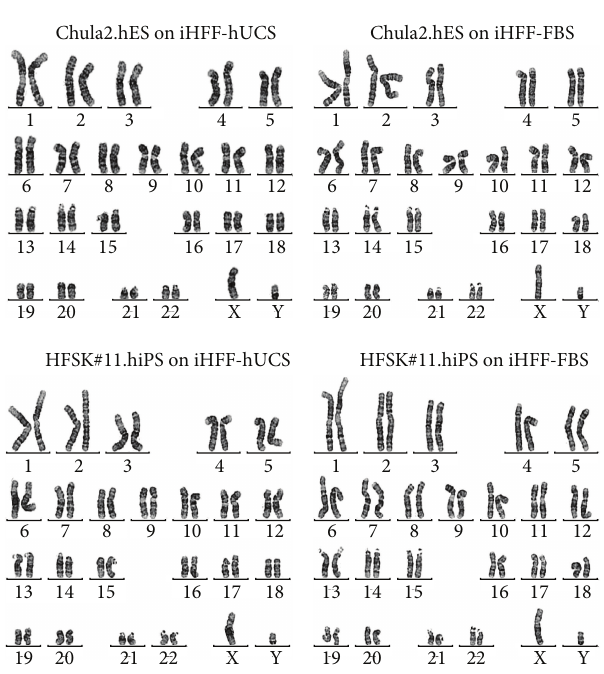
Figure 6: Karyotypic analysis of human pluripotent stem cell lines cocultured with inactivated HFF-hUCS. The karyotypic stability of hPSCs after prolonged coculture with inactivated HFF-hUCS was detected using the G-banding method. hPSC lines cocultured with inactivated HFF-hUCS maintained a normal karyotype similar to hPSCs lines cocultured with inactivated HFF-FBS. Chula2.hES maintained the 46,XY karyotype and HFSK#11.hiPS maintained the 46,XY karyotype on both types of feeder cells. iHFF-hUCS = inactivated HFF-hUCS and iHFF-FBS = inactivated